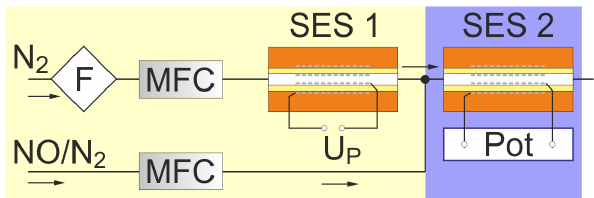
Figure 1. Experimental setup. MFC – mass flow controller, SES – solid electrolyte sensor, Pot – electrochemical measuring system, F – triple